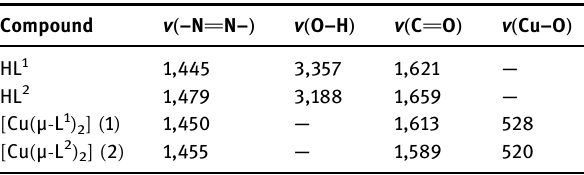
Table 1: Characteristic IR absorption bands for ligands and its